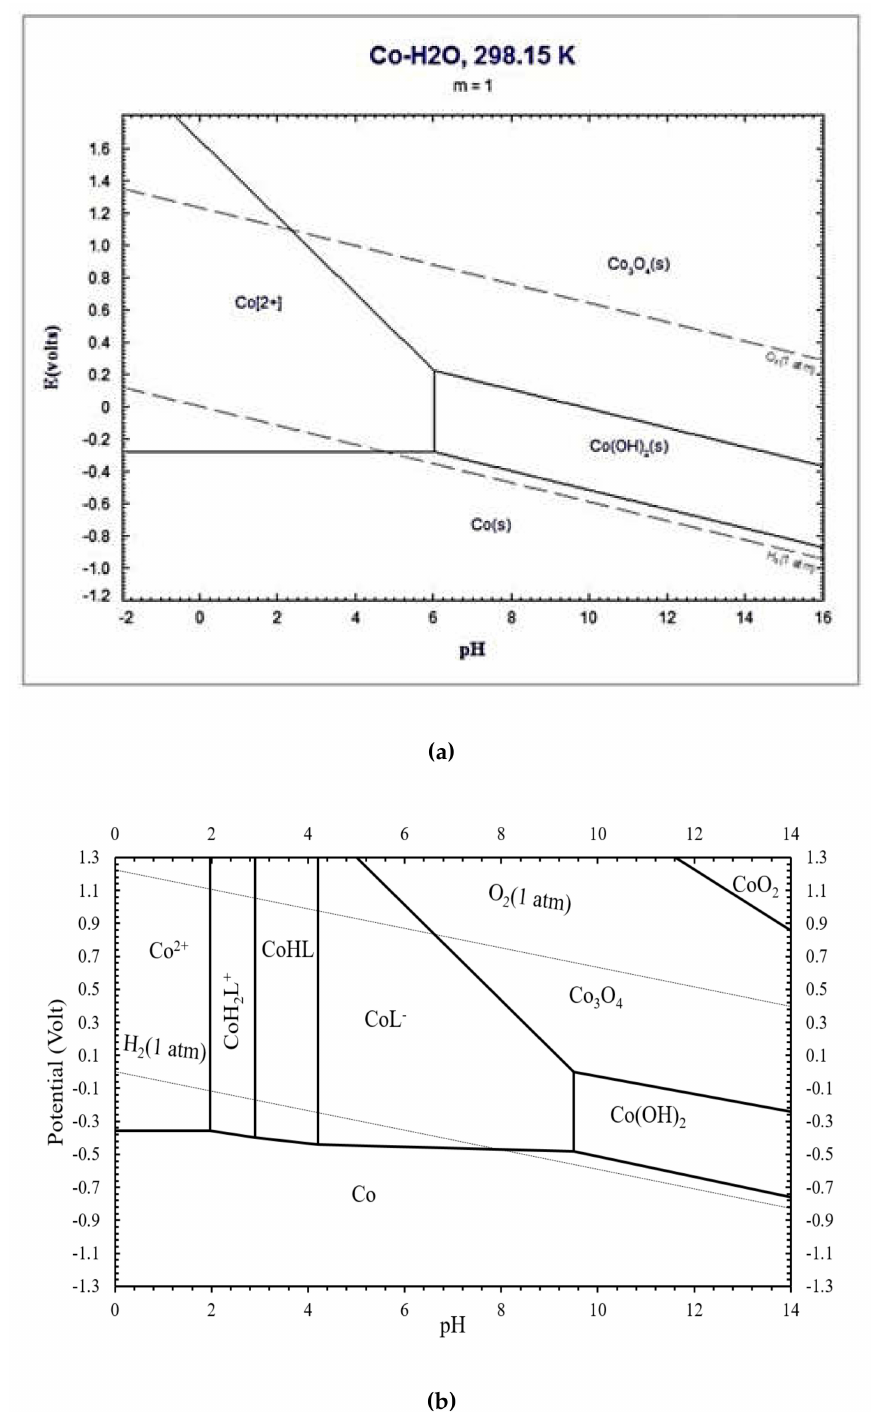
Figure 7. Pourbaix diagram for ( a ) Co-H 2 O system; ( b ) Co-H 2 O-citrate system at 298 K (total cobalt activity = 1 M, total citrate activity = 0.667